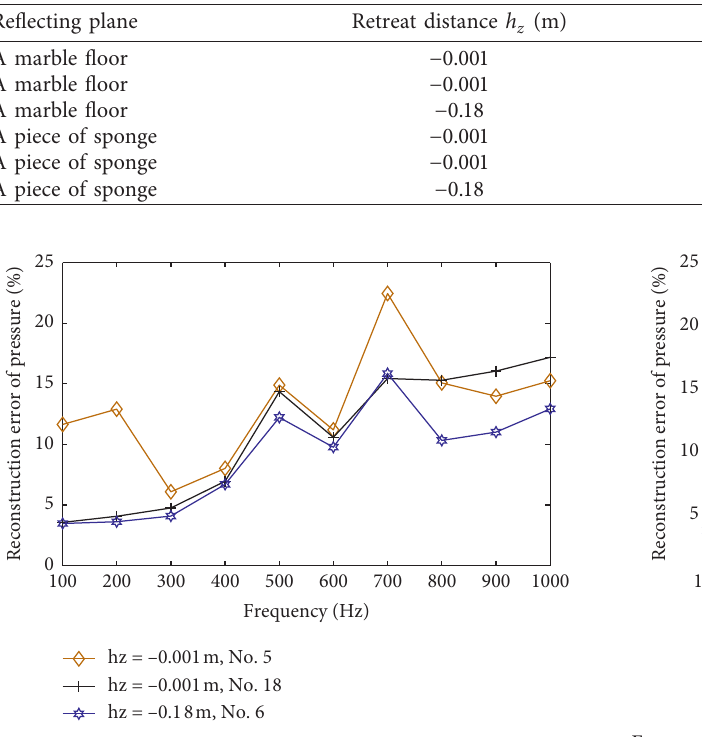
Figure 9: The reconstruction error of pressure versus the frequency with a marble floor as the reflecting plane.